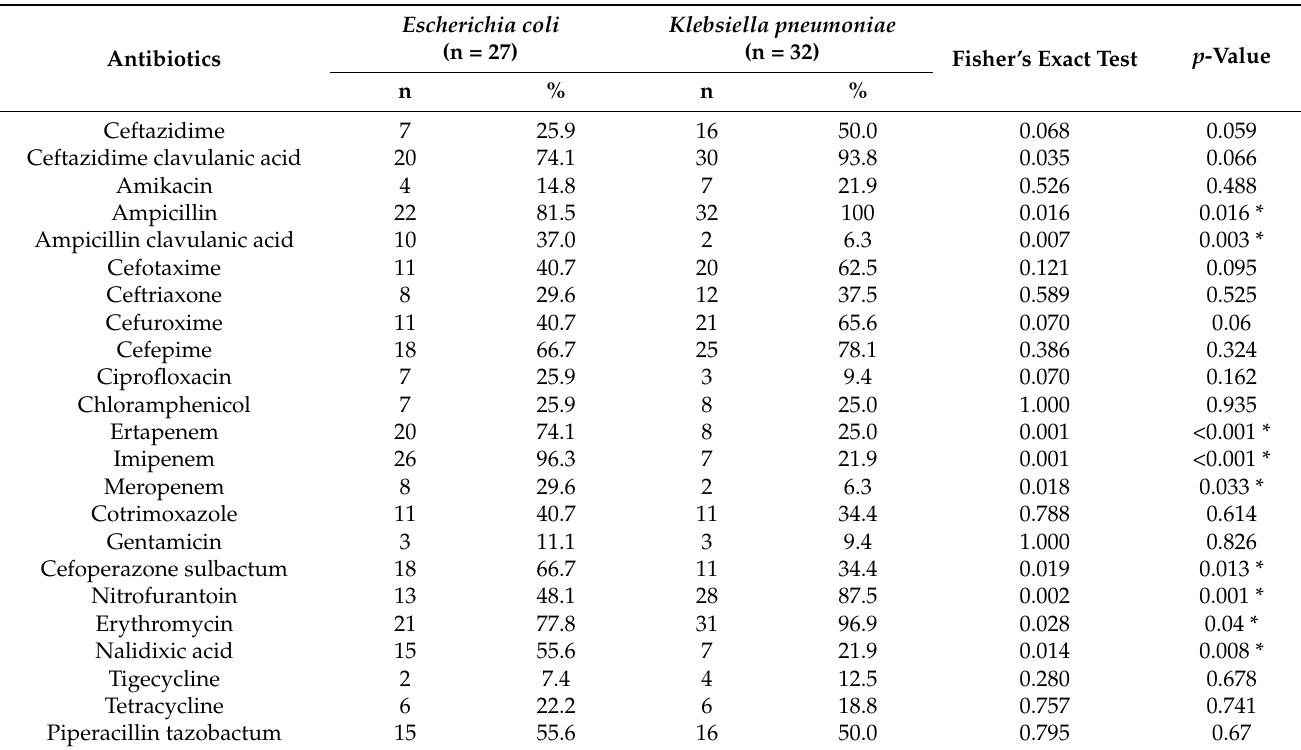
Table 3. Comparison in the difference between antibiotic resistance profiles of Escherichia coli and Klebsiella pneumoniae isolates using Fisher’s exact